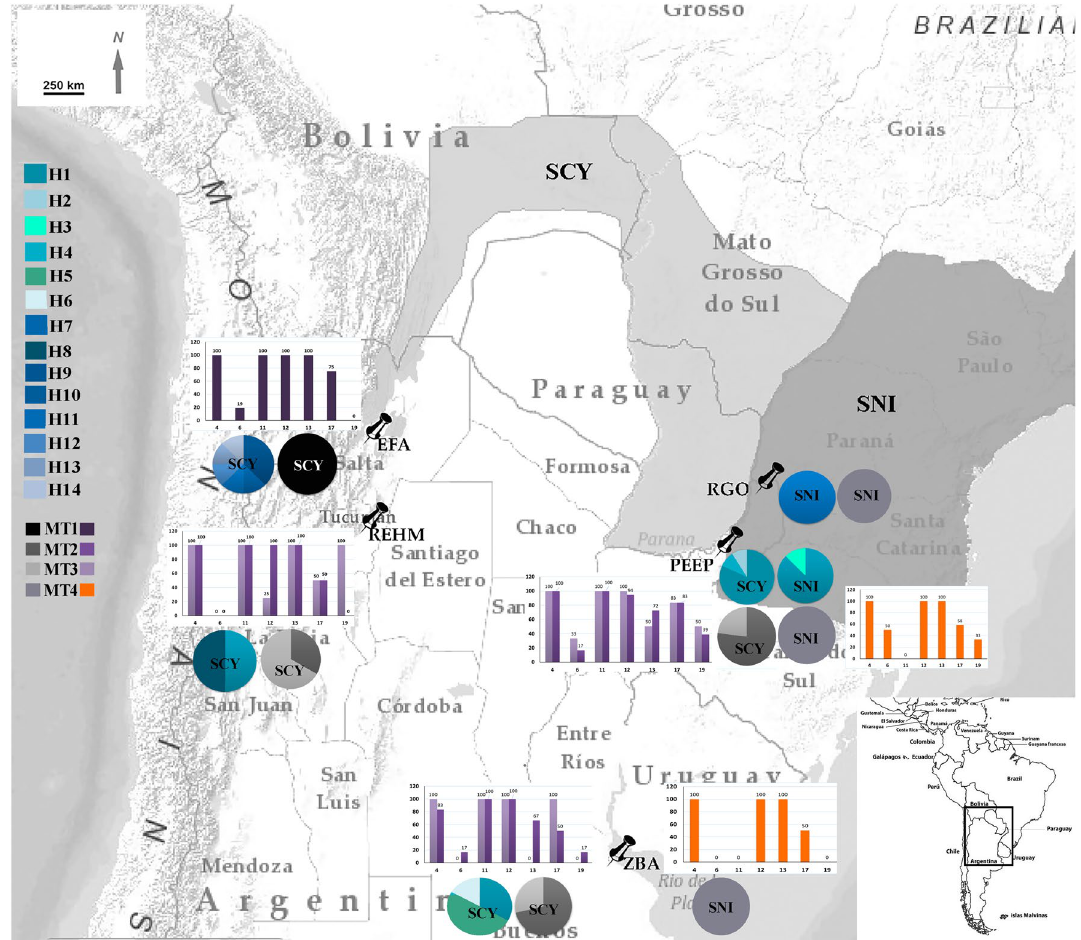
Figure 1. Map illustrating the southernmost natural distribution of capuchin monkeys in South America and location of the different Argentinian centers where samples were obtained. Modified from 59,60 and UICN species distribution maps. EFA Estación de Fauna Autóctona (Salta), REHM Reserva Experimental Horco Molle (Tucumán), ZBA Zoológico de Buenos Aires, PEEP Parque Ecológico El Puma, RGO Reserva Güira Oga, SCY Sapajus cay , SNI Sapajus nigritus . Percent of heterochromatic blocks in different polymorphic chromosome pairs of each center are shown in bar diagram (purple scale and orange represent the chromosomal frequencies of each morphotype). Haplotype (H_) and morphotype (MT) frequencies in each center are shown in the pie charts and their size is proportional to sample size. The haplotypes and morphotypes are